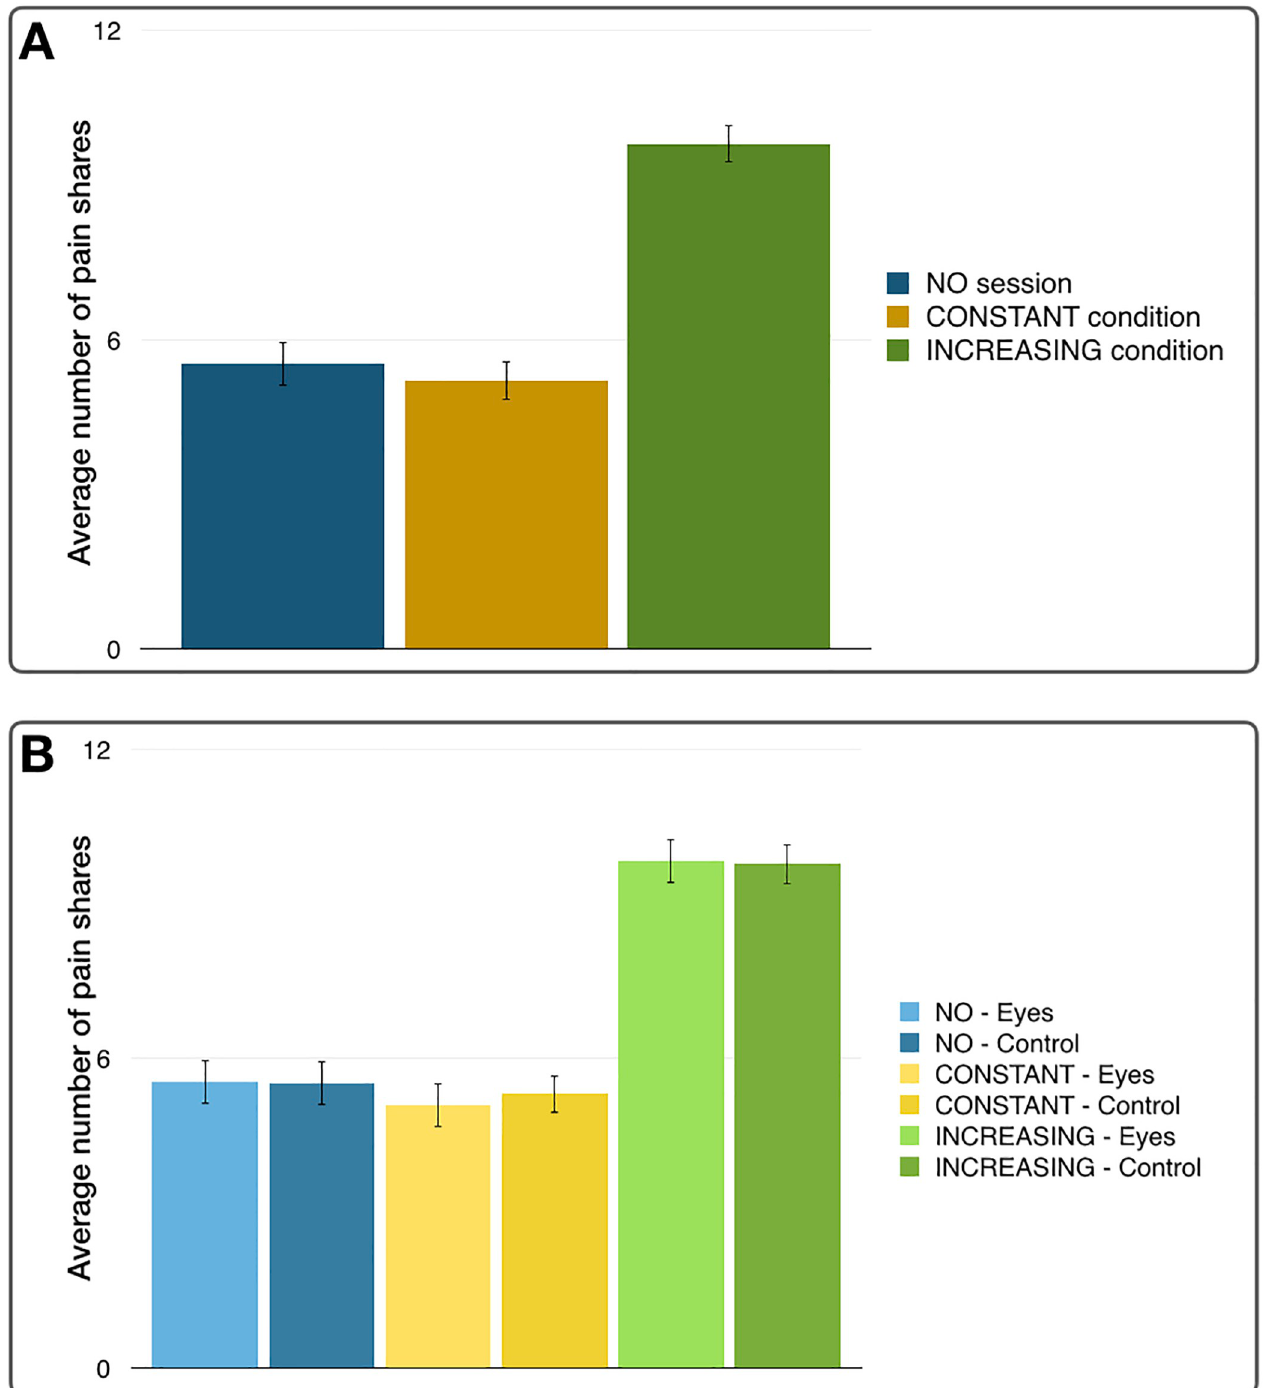
Fig 2. A. Average number of shared pain stimulations by session. It increased during the INCREASING session, while there was no significant difference between the NO session and the CONSTANT session. B. Average number of shared pain stimulations by session and by eye or control cues. There was no significant difference between eye or control cues throughout all